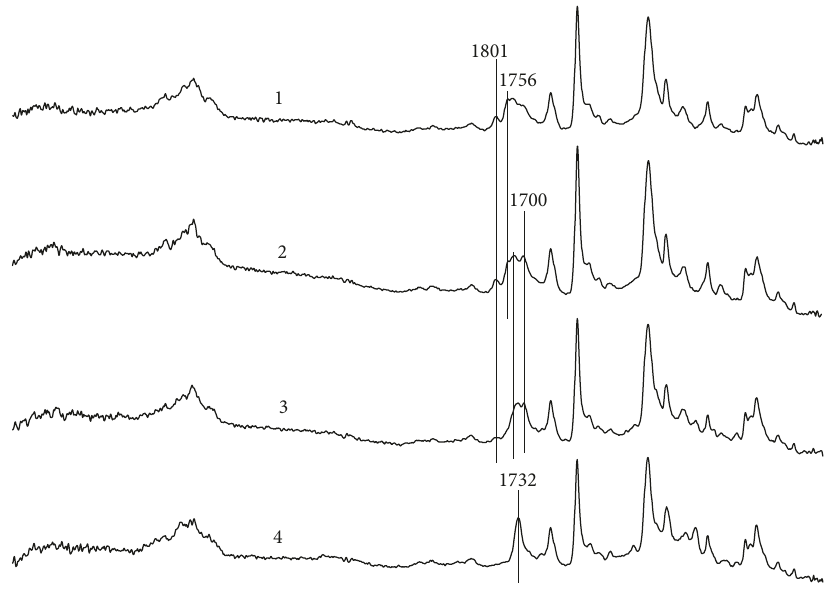
Figure 1: FTIR spectra of the cured neat ROL-II (I-IV) samples prepared by heating in the thermal regime up to the following fi nal temperatures T : 1: 320 ° C; 2: 260 ° C; 3: 220 ° C; 4: 180 ° fin cur